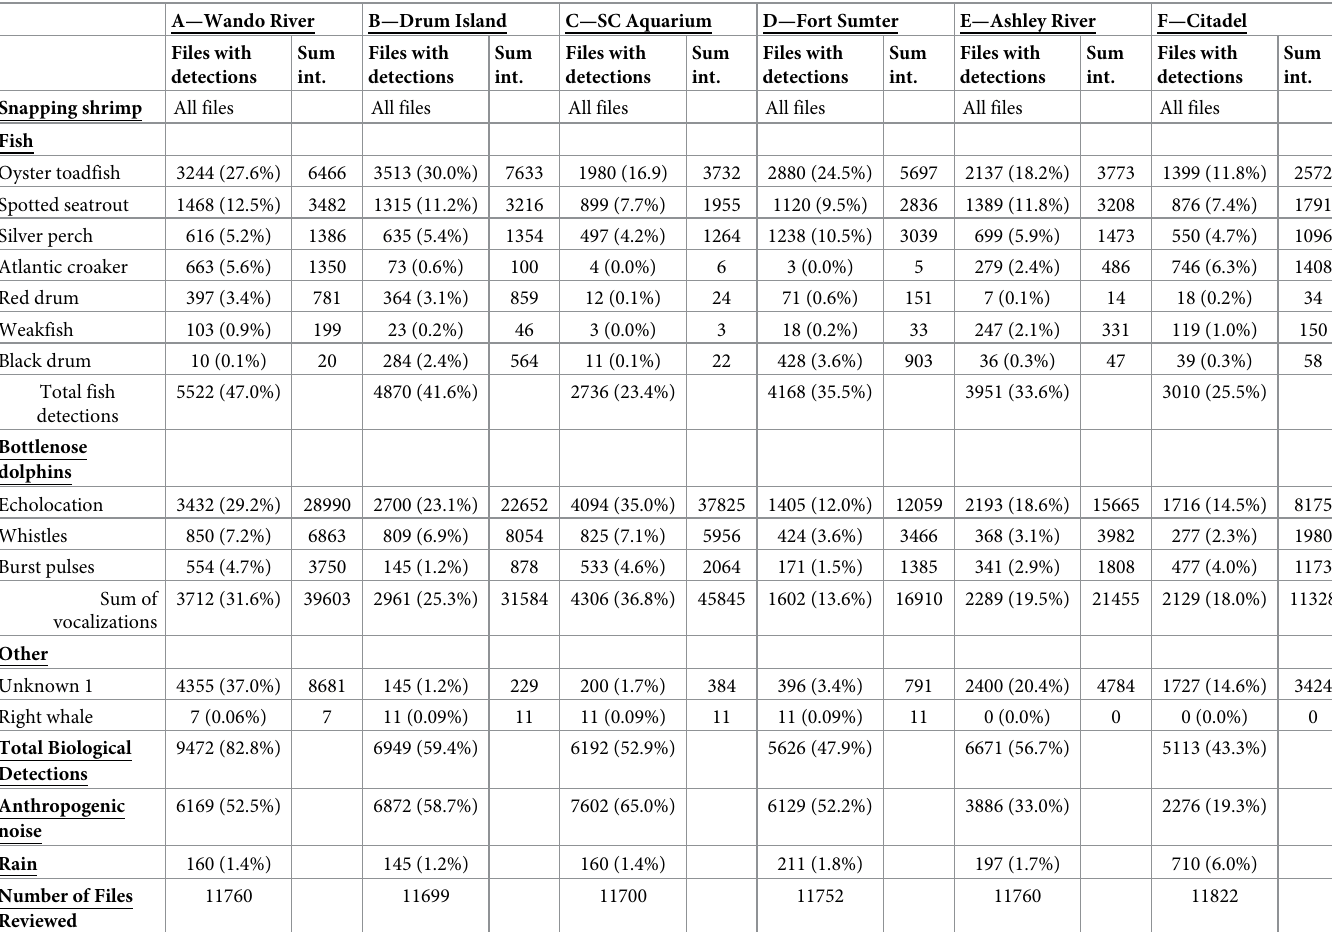
Table 2. Prevalence of sounds at each station in Charleston Harbor from December 2017 to June